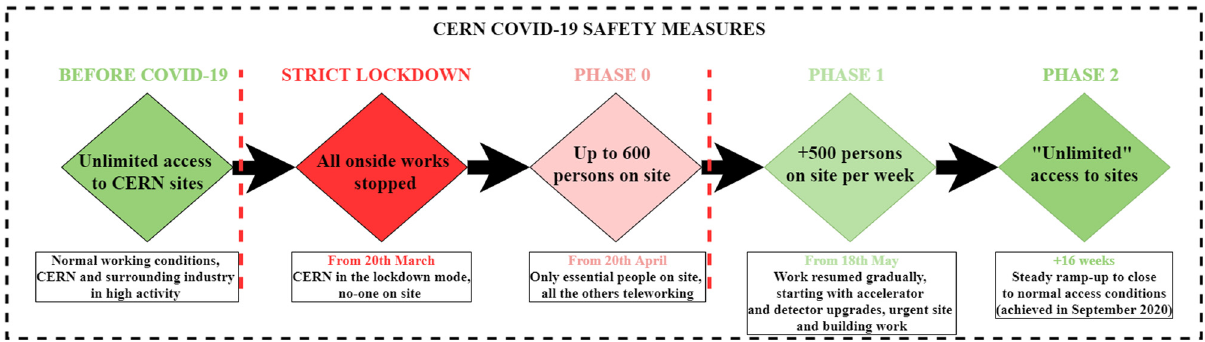
Figure 3: Phases of limitation of users ’ access to CERN